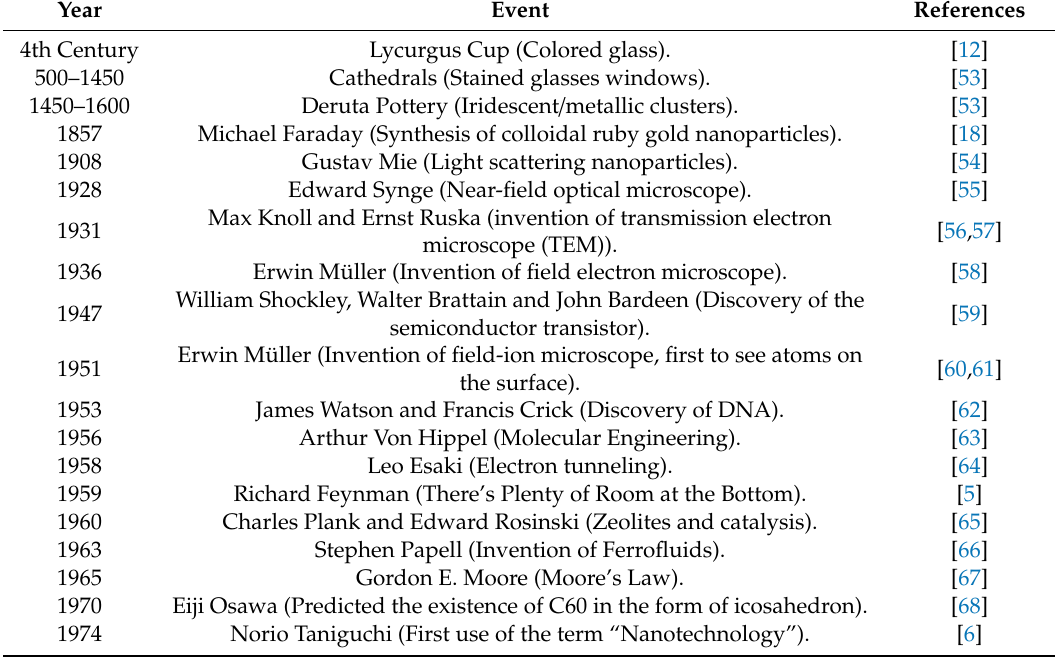
Table 1. Evolution Timeline of Nanoscience and